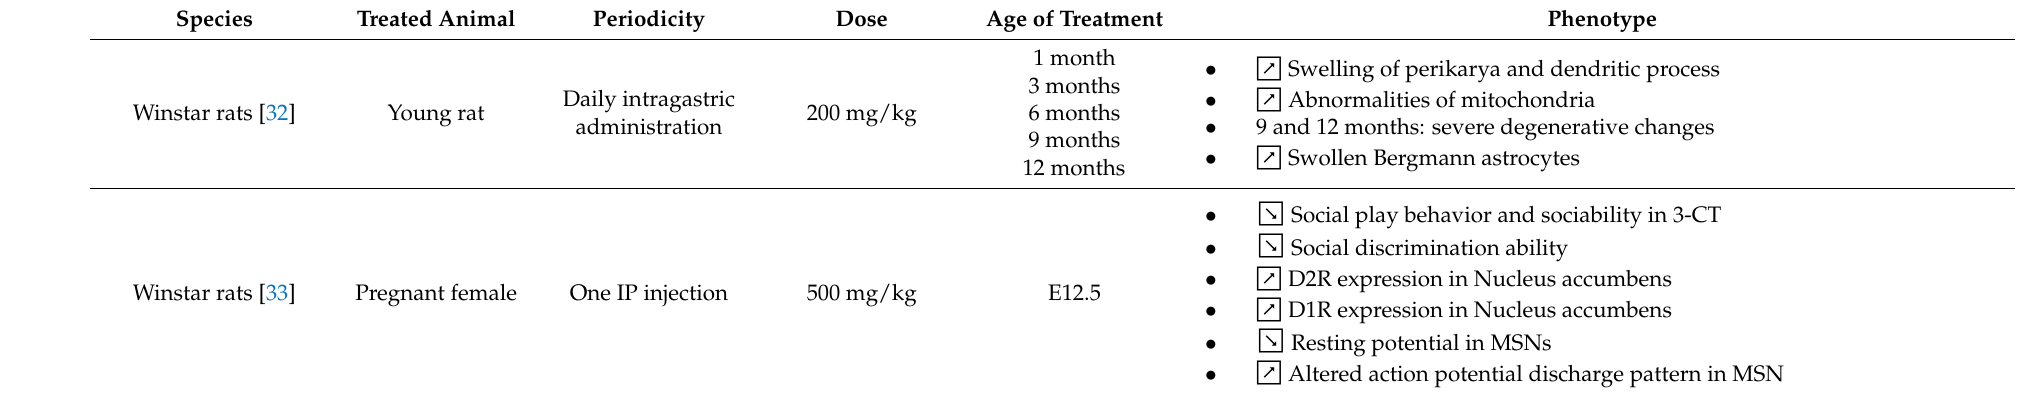
Table 1. Various outcomes in various animal models of valproic acid administration during development in relation with species, dose and age. This table reca- pitulates the different VPA models and their phenotypes. IP: Intraperitoneal injection, USV: Ultrasonic vocalizations, D1R and D2R: D1 dopamine receptor and D2 dopamine receptor, PC: Purkinje cells, MOR: Mu opioid receptor, PV: Parvalbumin interneurons, mPFC: median Prefrontal cortex, GABAP3: GABA receptor subunit p3.